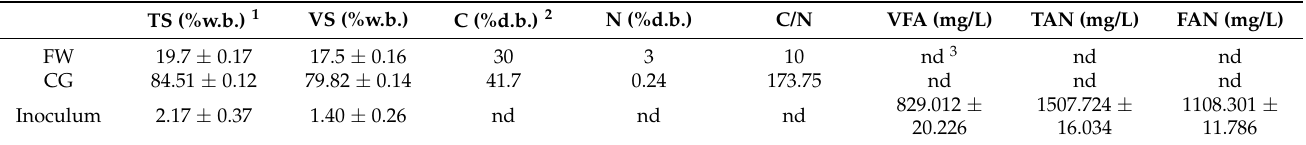
Table 1. Characteristics of FW and CG used as substrates, and the sludge used as inoculum (TS, total solid content; VS, volatile solid content; VFA, volatile fatty acids; TAN, total ammonia nitrogen; FAN, free ammonia nitrogen; C, carbon content; N, nitrogen